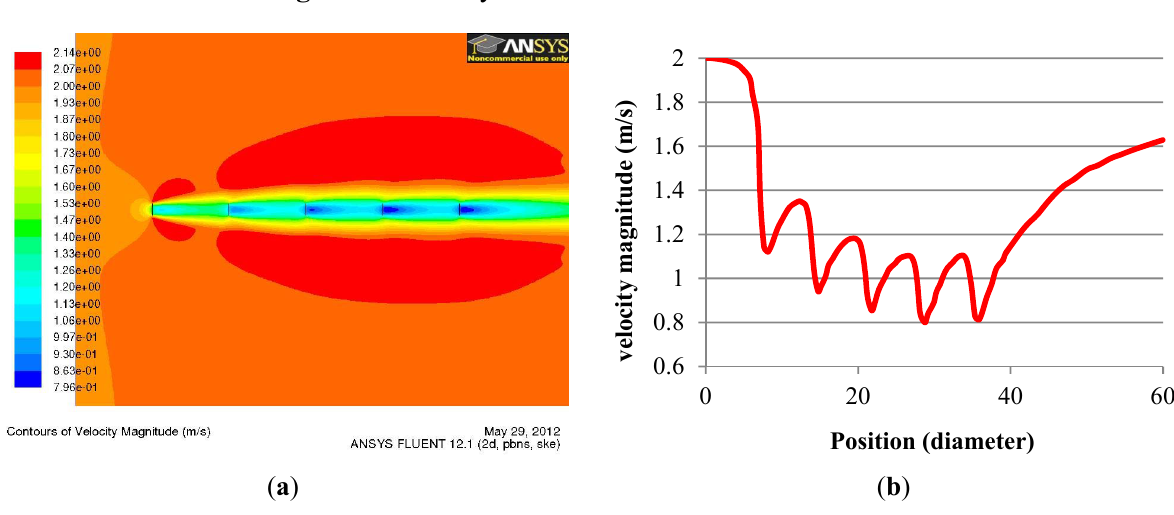
Figure 3. Velocity field around five turbines in a row.